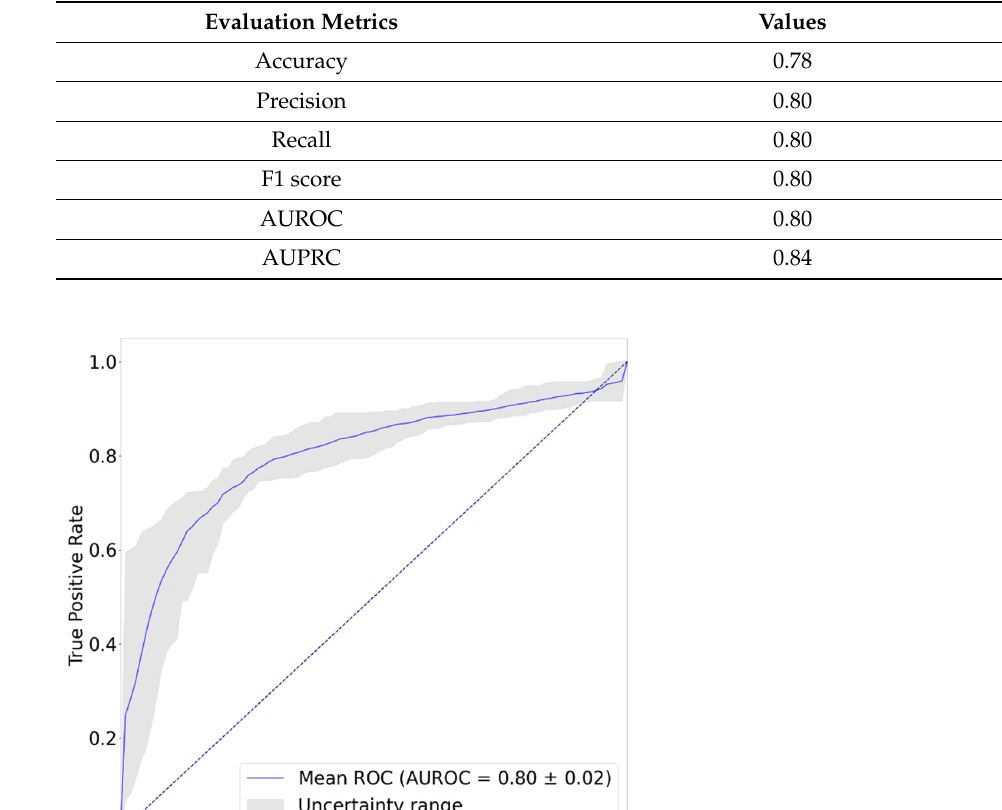
Table 2. Hemiplegic gait classification performance of the proposed model ( N = 84). AUROC: area under of receiver operating characteristic curve; AUPRC: area under of the precision-recall curve.